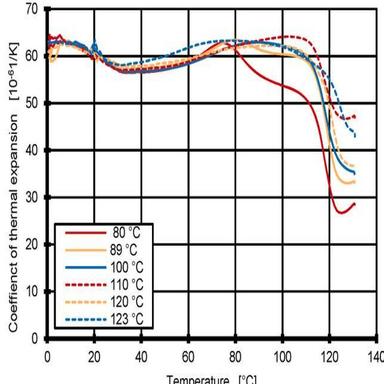
Temperature dependent LCTE for different initial glass transition temperatures.Tg